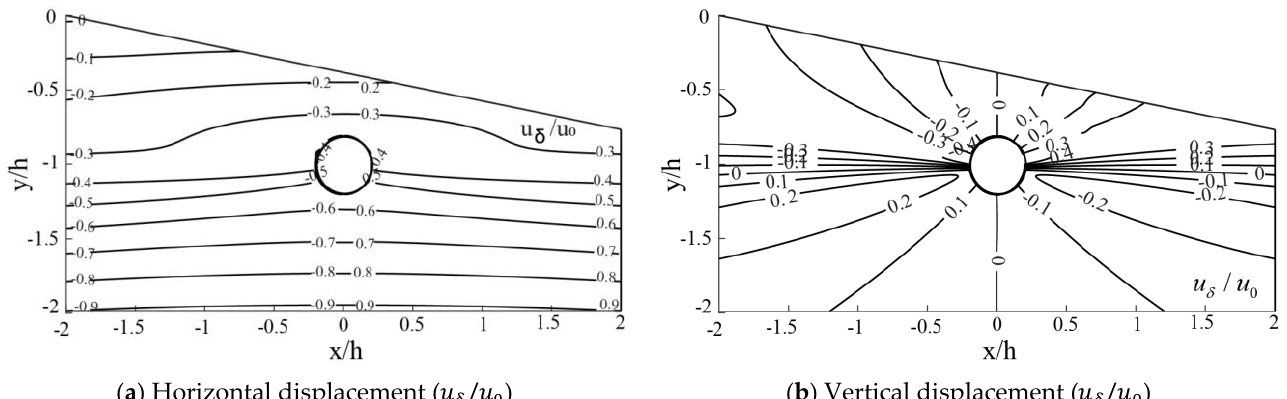
Figure 9. Displacement induced by Equations (33) – (35) (uniform convergence) and Equations (50) – (56) (ovalization).